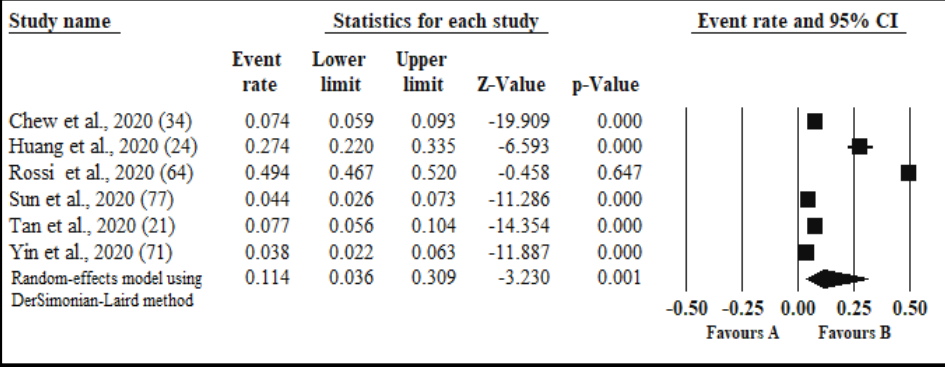
Figure A3. Forest plot for the studies on the prevalence of Post-traumatic stress syndrome (PTSD) among healthcare workers. The squares and horizontal lines correspond to the study-specific event (anxiety) rates and 95% confidence intervals (CIs). The diamond represents the pooled prevalence and 95% CI of the overall population. The overall pooled PTSD using a random effects DerSimonian-Laird method was 11.4% (95% CI: 3.6–30.9).